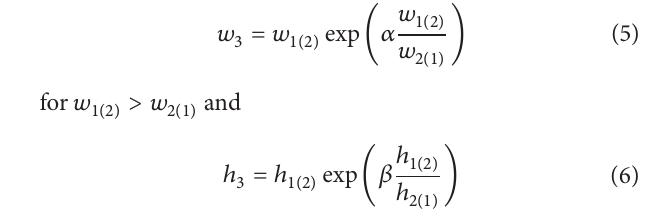
while its direction follows the shape of the river